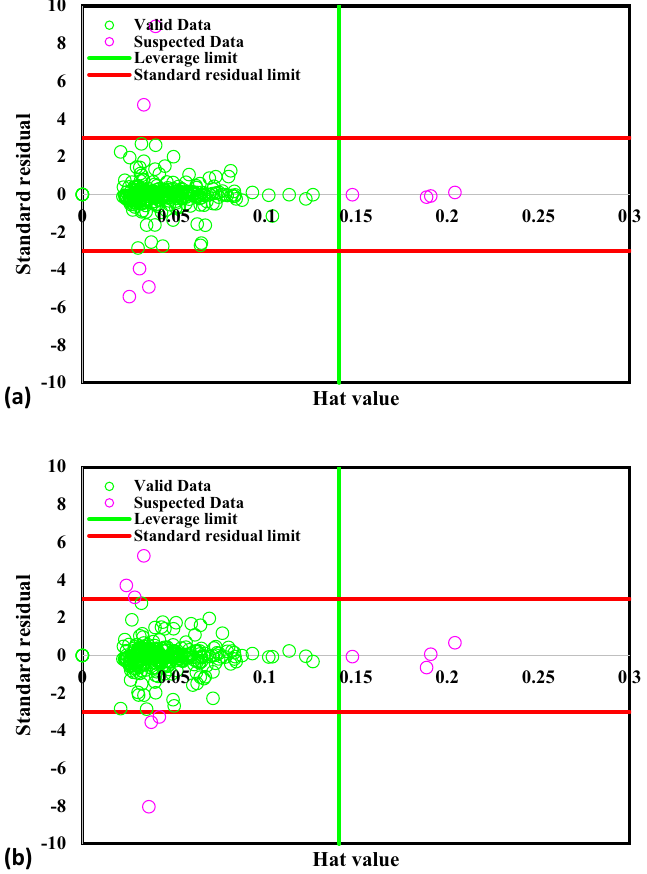
Figure 4. Detection of suspicious data for ( a ) PSO–ANFIS, ( b )